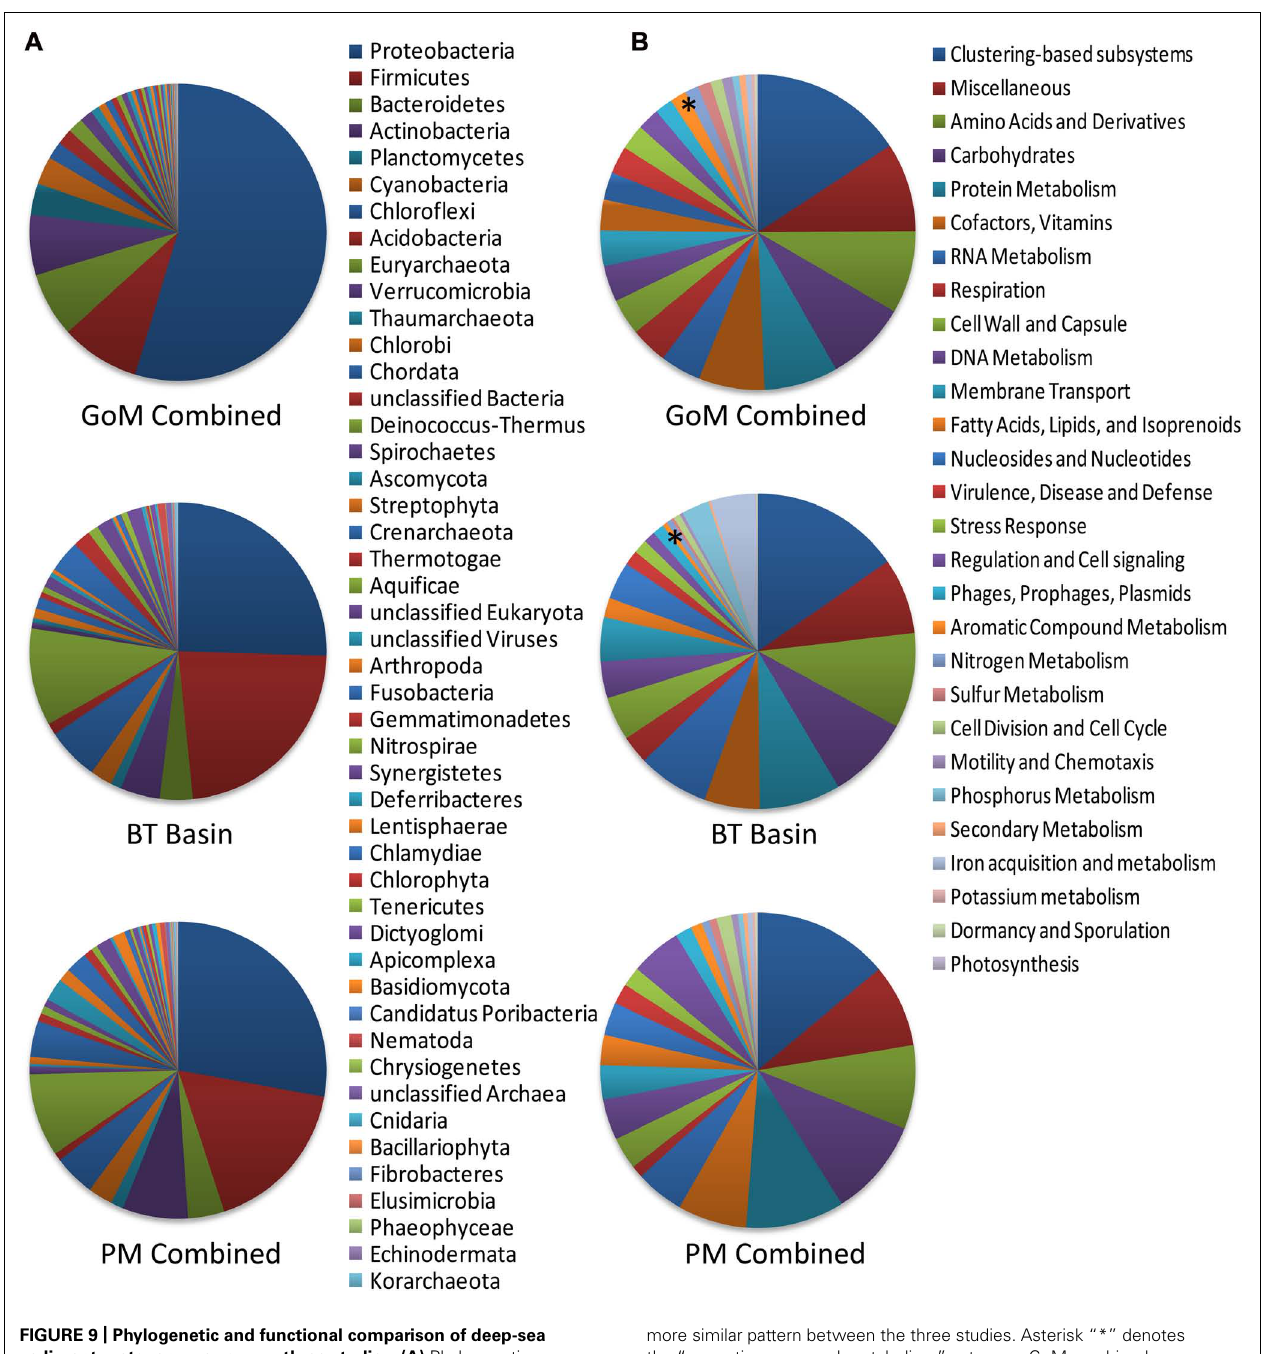
more similar pattern between the three studies. Asterisk “*” denotes the “aromatic compound metabolism” category; GoM combined, represents the collective data from GoM315, GoM278, and GoM023; PM combined, represents the collective data from PM01*, PM01, and PM50. The BT basin represents a single